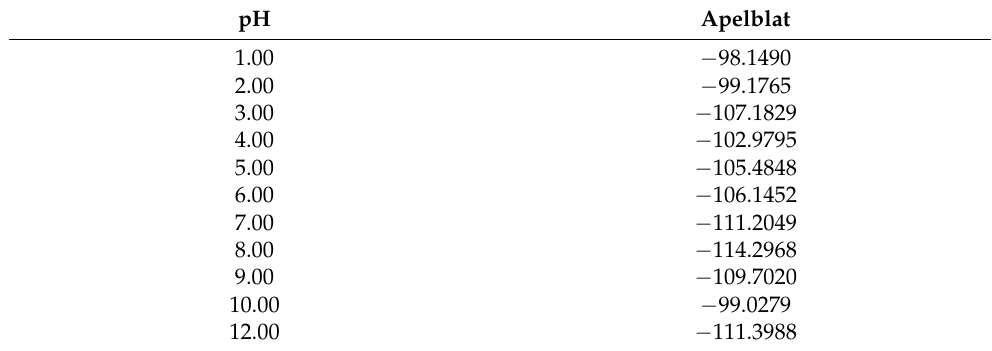
Table 9. Calculation results of AIC value of phenylglycine correlation solubility and temperature model.